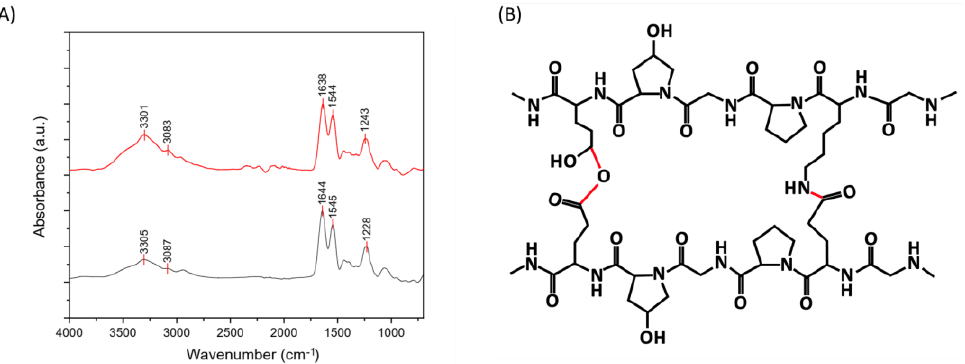
Figure 1. ( A ) FT-IR spectra of uncrosslinked (down) and cross-linked (up) collagen membranes. ( B ) Chemical structure of collagen after cross-linking.